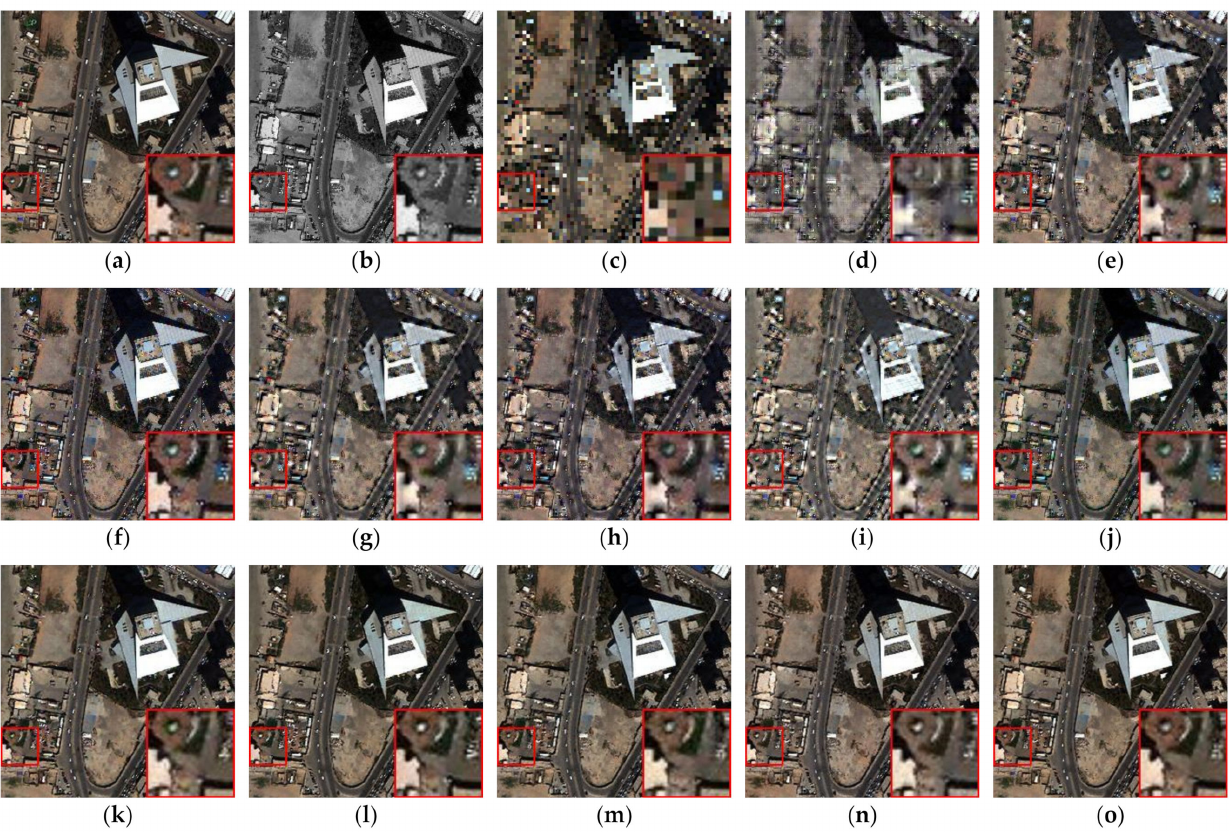
Figure 12. Results for four bands using the WorldView-2 dataset (resolution, 256 × 256 pixels):